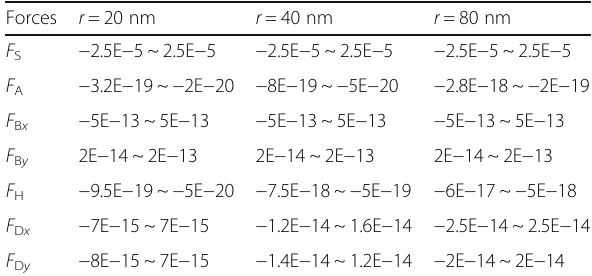
Table 4 Ranges of driving force and interaction forces, A = 4:1. Ranges of driving force and interaction forces between particles in the nanofluid ( A = 4:1, Ra = 10 5 , φ = 0.01) Forces r = 20